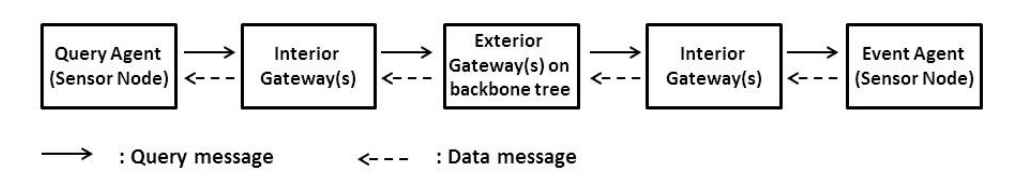
Figure 2. Query and event data message flow among Federated Sensor Network